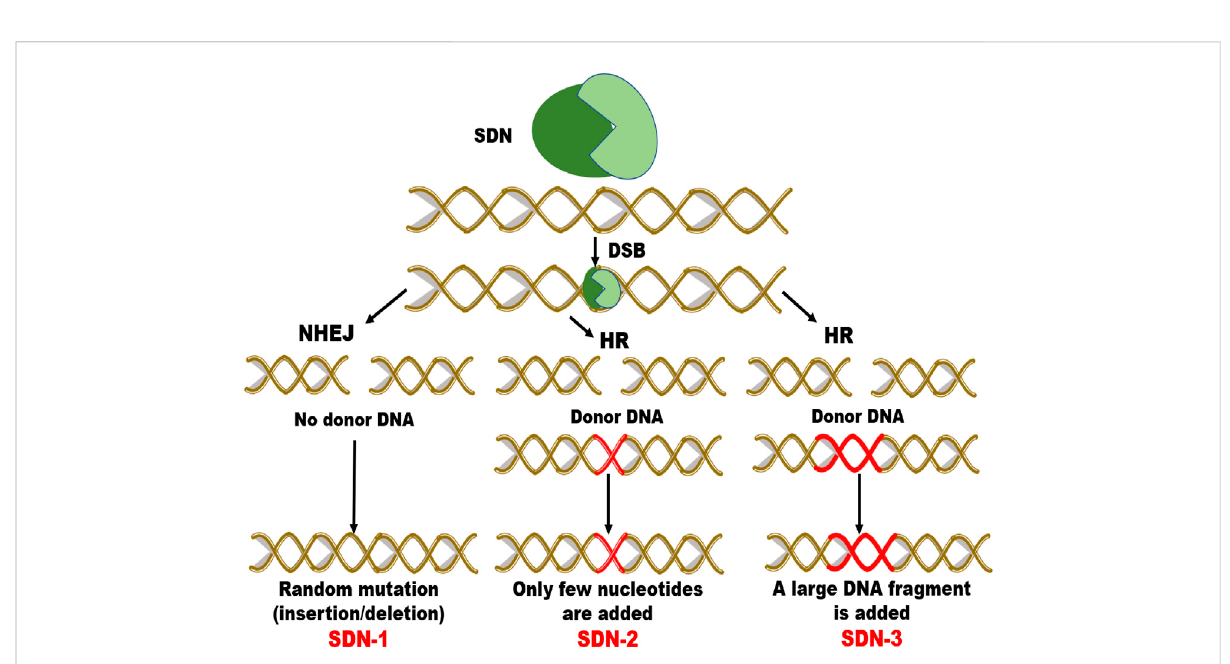
FIGURE 4 Schematic diagram of modi fi cation by site directed nuclease (SDN- 1, SDN-2 and SDN-3) types. Double strand break (DSB) is repaired via non- homologous end joining (NHEJ) or homologous recombination (HR). SDN1 results in random insertion/deletion, SDN2 induces addition of few nucleotides and SDN3 inserts a DNA